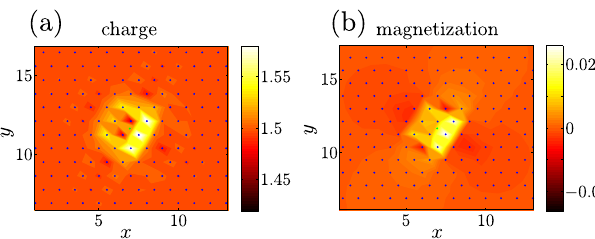
FIG. 7. Charge (a) and magnetization (b) density distributions around a vortex. The vortex is indicated by the green dot at the center. The system parameters are as follows: J ! 1 , L ¼ 30 , h ¼ 0 at 3 = 4 electronic filling.